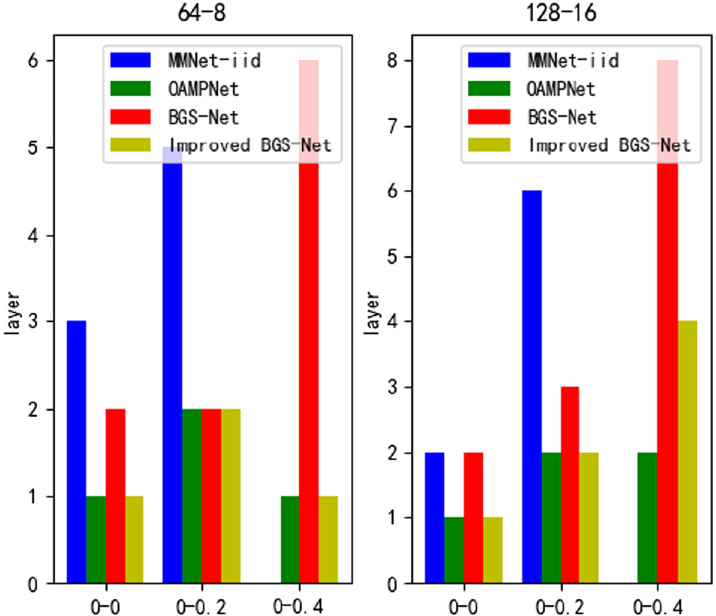
Fig. 28 Under different antenna configurations, when the SER reaches 10 − 5 in the SAUE system and the MAUE ( ξ r = 0, ξ t = 0.2 , mue 2) system, the SER reaches 10 − 4 in the MAUE ( ξ r = 0, ξ t = 0.4 , mue = Required number of network